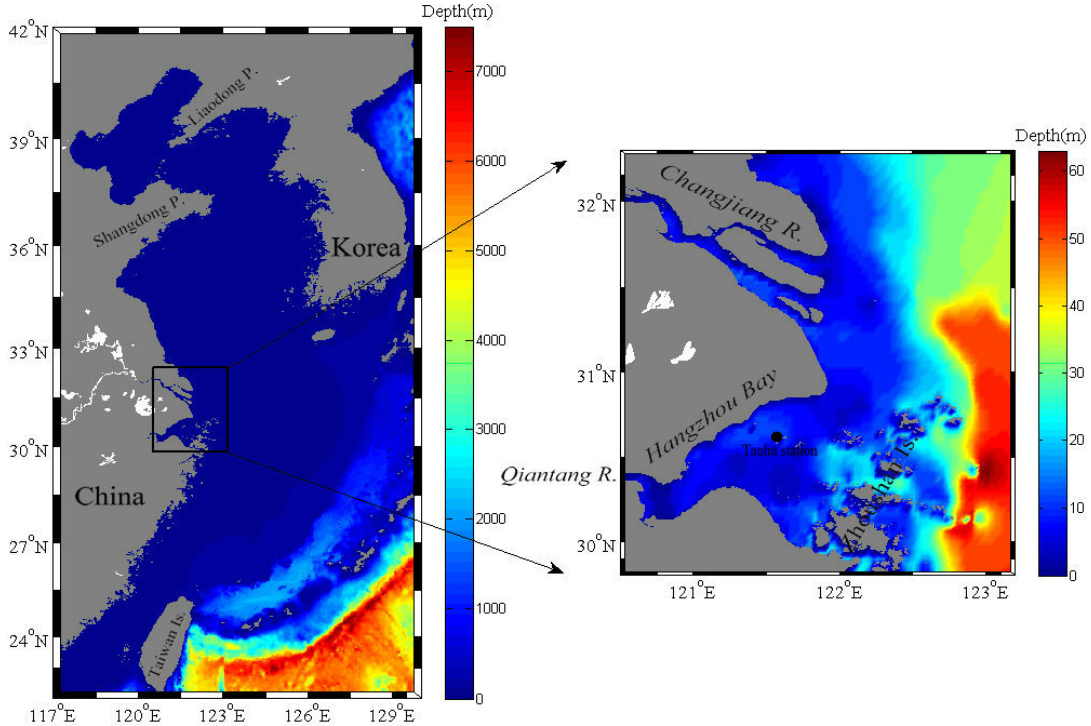
Figure 1. Location map of the study region .